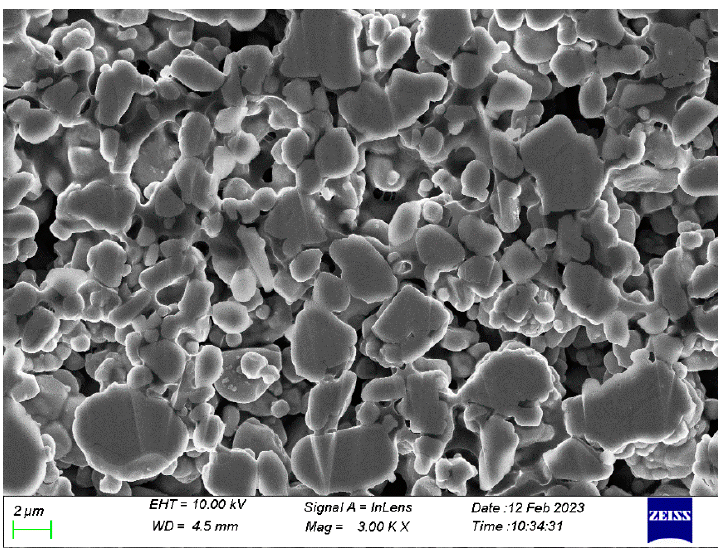
Figure 4. Cross-sectional morphology of NCM523.